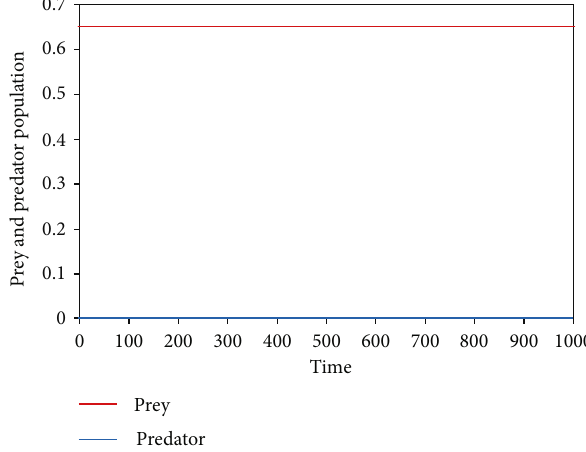
Figure 11: Time series solution of system (4) about the equilibrium point E 2 with parametric value as in Table 2 except H = 0 : 5, c 2 = = 0 : 35, α = 0 : 5, and β = 10 . 0 : 1, c 1